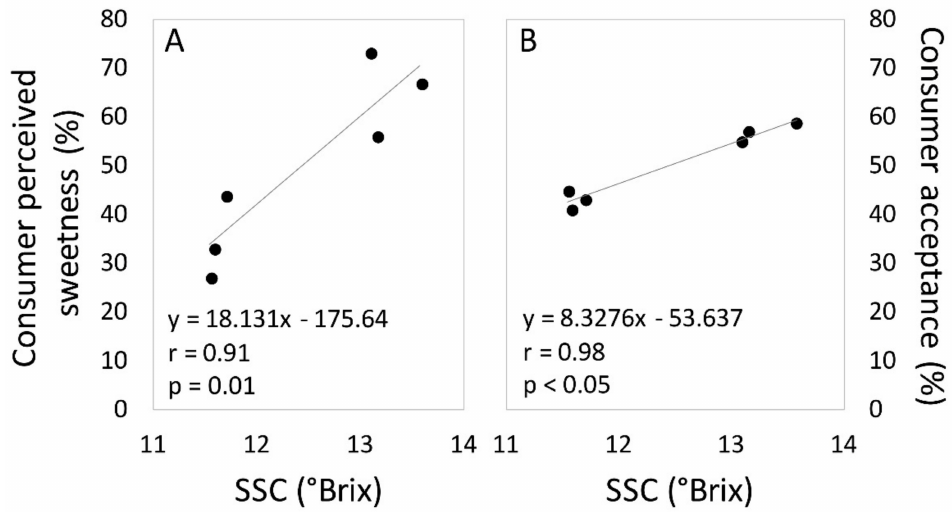
Figure 3. Relationships between soluble solid content and consumer perceived sweetness ( A ) and consumer acceptance ( B ). The relationships are fitted with linear regression, where equation, r , and p -values are